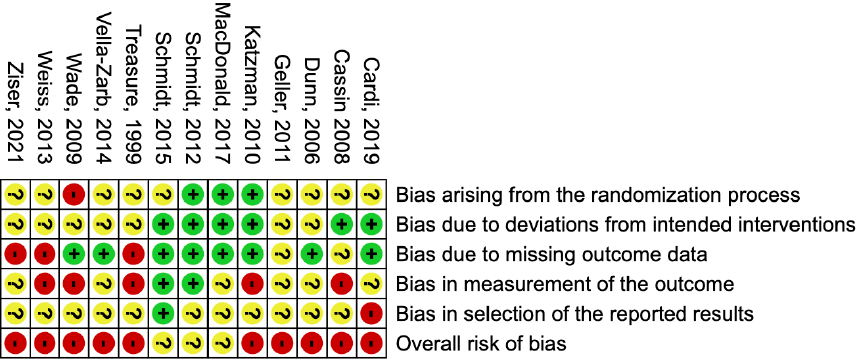
Figure 3. Summary table showing the risk of bias assessments for each domain and overall, for all included